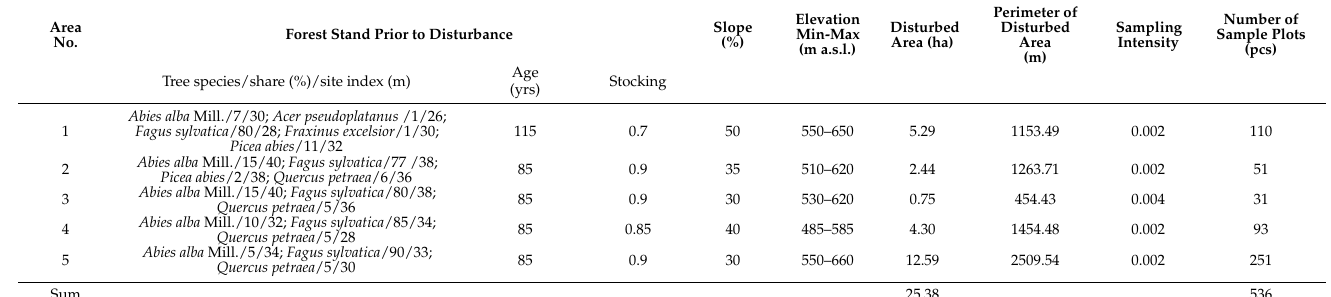
Figure 6. Location of disturbed areas within University Forest Enterprise of Technical University in TA \l “Mokroš et al. 2017” \s “Mokroš et al. 2017” \c 1 Zvolen, Slovakia. Table 7. Basic characteristics of disturbed areas and respective forest stands prior to the disturbance.